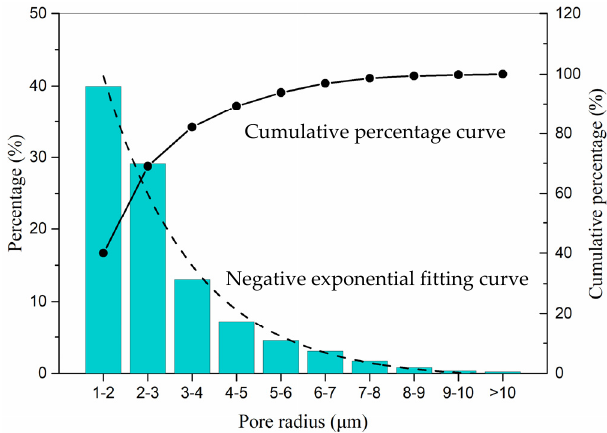
Figure 5. Pore quantity distribution at the micro–scale.